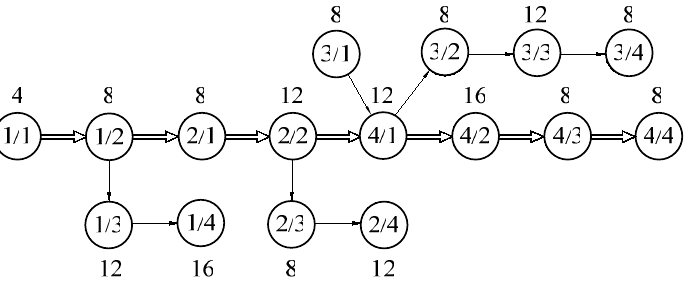
Fig 7. Network of dependences for input data in Table 1